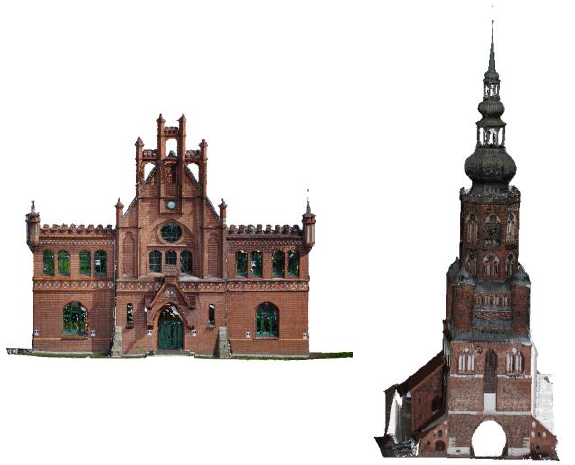
Figure 6. The results of texture